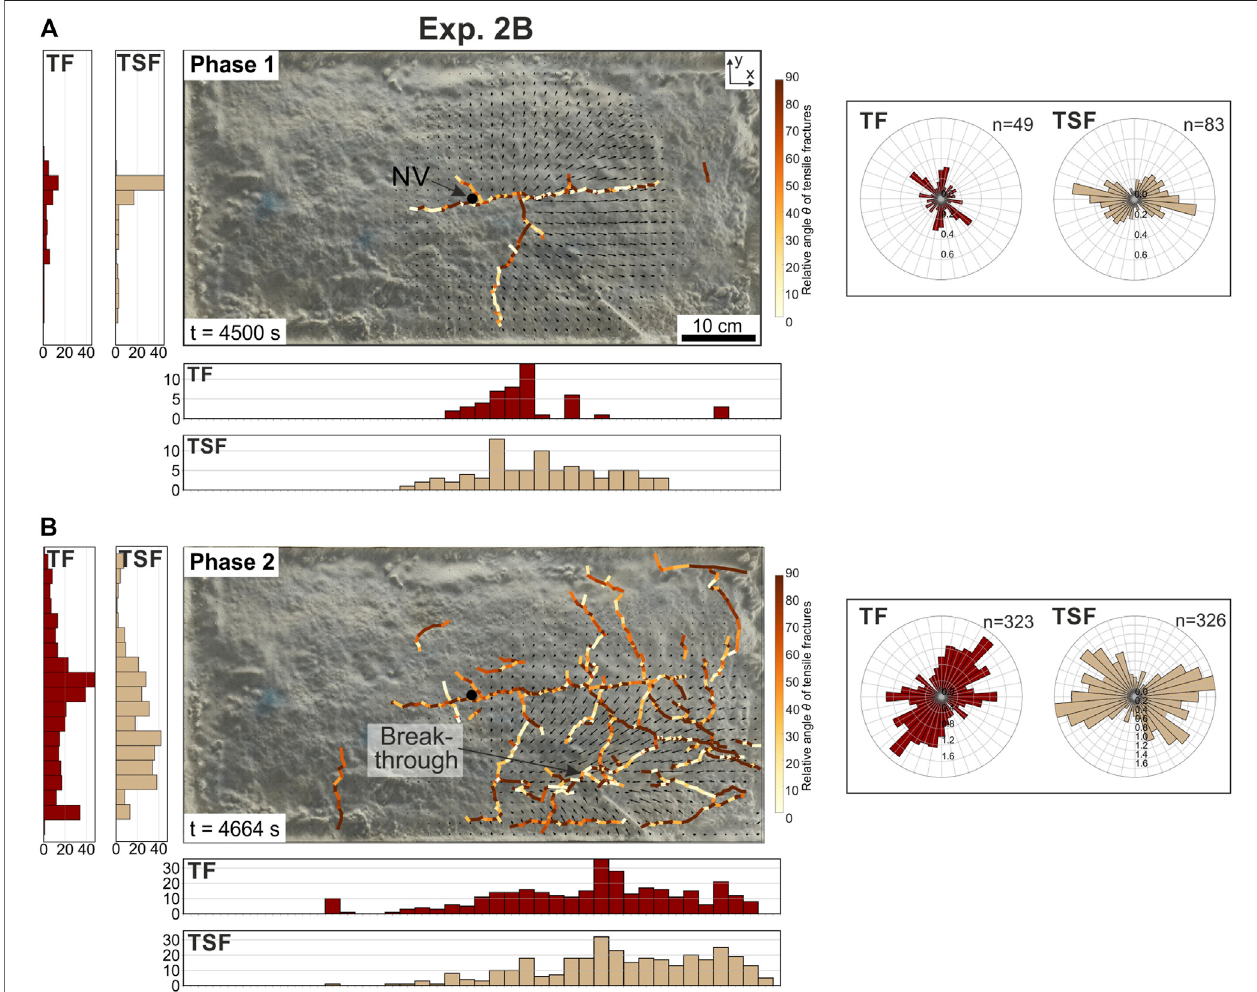
FIGURE 11 | Results of the fracture mode analysis of the 3D experiment 2B for (A) phase 1 and (B) phase 2 showing the opening mode of the fractures color- coded.Thefracturemodeisdeterminedbytherelativeangle θ betweenthestrikeofthefractureandtheclosestdisplacementvector(blackarrows).If θ islargerthan45 ° , thefractureisdominatedbytensileopening(red).Incase θ issmallerthan45 ° ,thefractureisdominatedbytensile-shearmovement(orangetobeige).Notethattracesof compactivefracturewereinvisibleonthesurface.Thebarplotsattheleftandthebottomdisplay theamountofthespeci fi cfracturetypes forcertain intervalsalong the y- and x-axis, respectively. Rose diagrams display the strike angles β of the tensile (TF) and tensile-shear fractures (TSF).